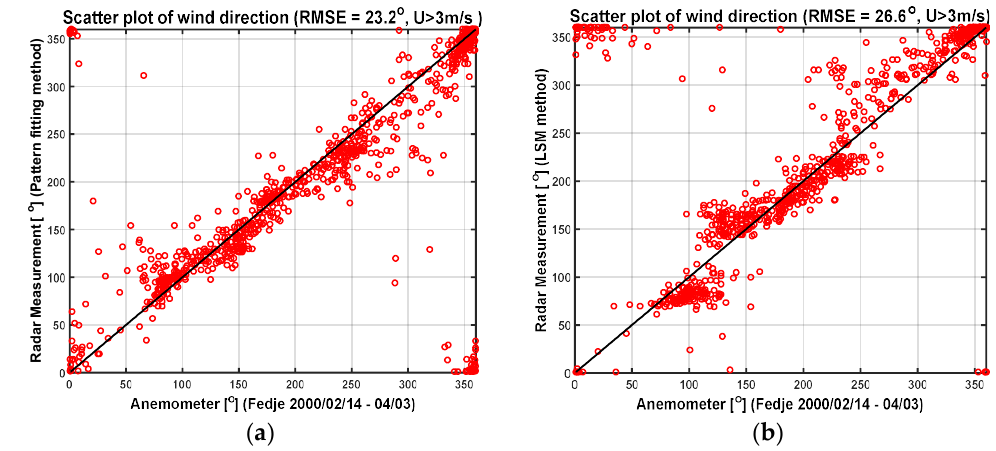
Figure 9. Comparison of wind direction measured by radar using the pattern-fitting method and the least-square minimum (LSM) method during the Fedje experiment ( U 10 > 3m/s). ( a ) Pattern-fitting method; ( b ) LSM method provided by Gurgel.